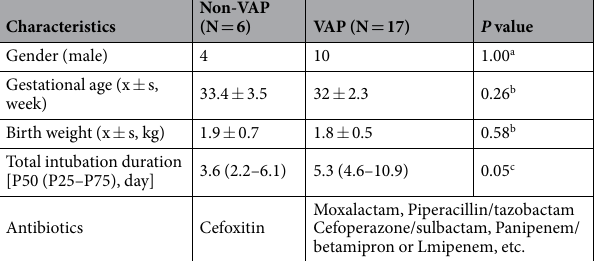
Table 2. Comparison of demographic and clinical characteristics between non-VAP and VAP infants among neonates with NRDS in the study. a Based on Fisher’s exact test. b Based on unpaired Student’s t-test. c Based on Mann–Whitney U test.